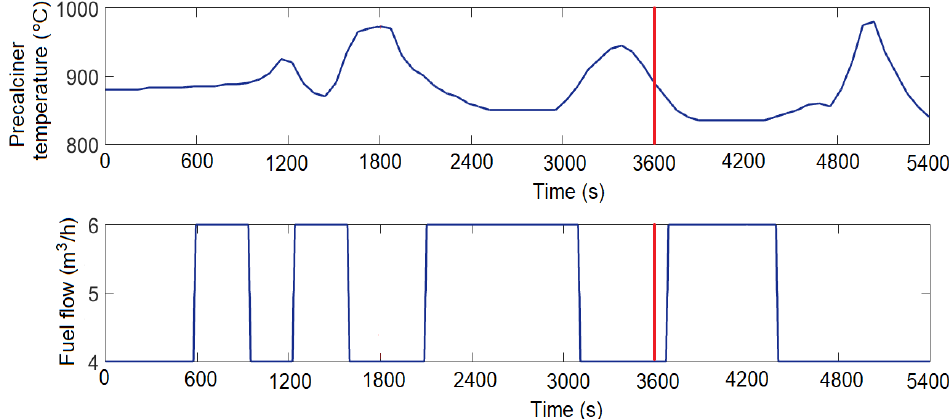
Figure 2. Results of the experiment with a pseudo-random binary sequence (PRBS).